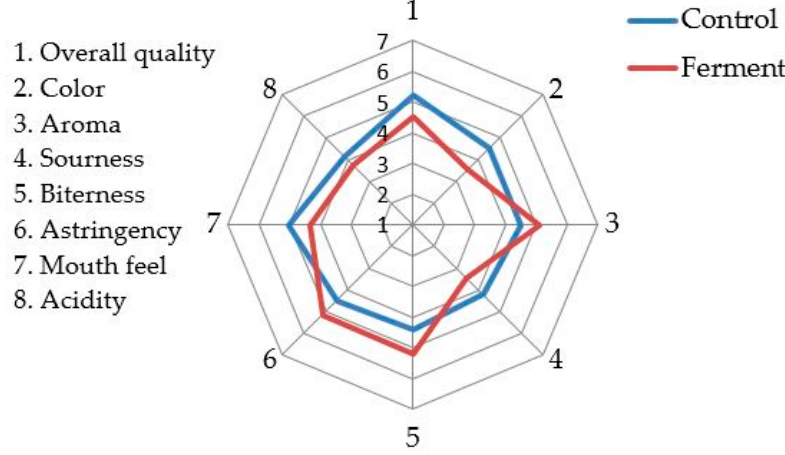
Figure 9. The consumer acceptability ratings of fermented and non-fermented co ff